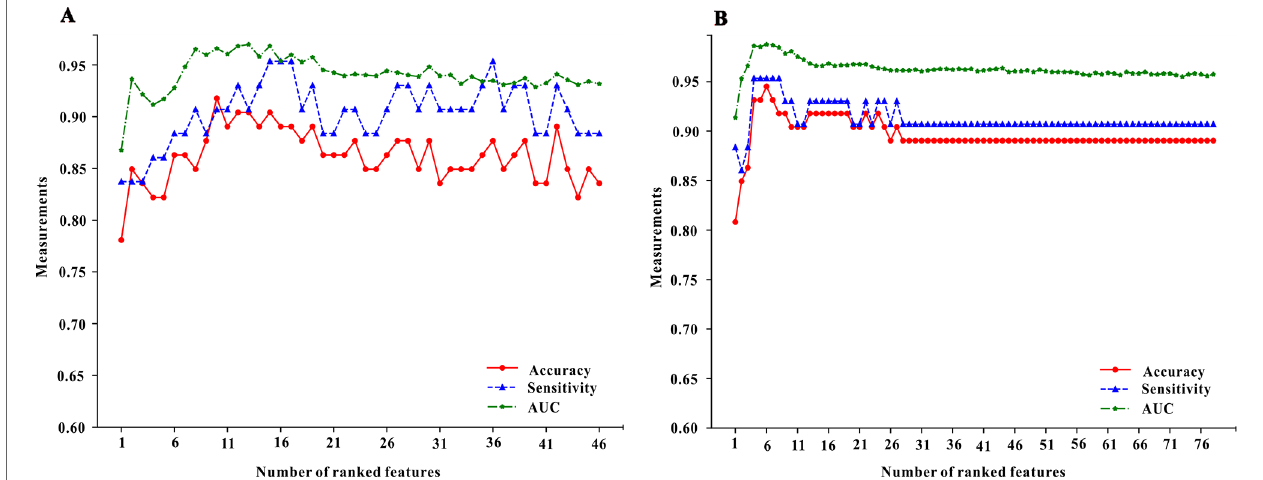
FIGURE 3 | The forward feature selection results for the model of pre-administration variables (the A part of figure 3) and the model of mix-variables before and after administration (the B part of figure 3). We examined the predictive performance of the most prominent feature and identified the point at which there was no considerable gain in accuracy, sensitivity, and area under the curve (AUC), when adding the feature of the next highest ranking one to the model. The optimum values were obtained when these three measurements defined the most discriminative features.